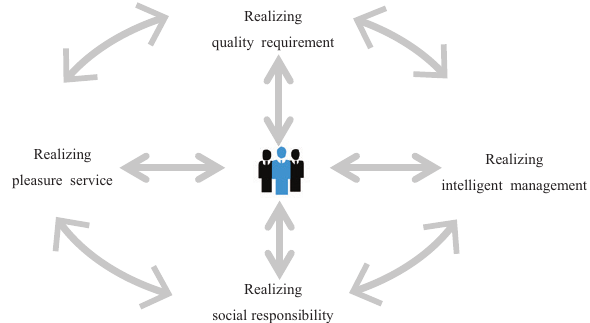
Figure 4. Logical structure diagram of the 4R mode of modern property